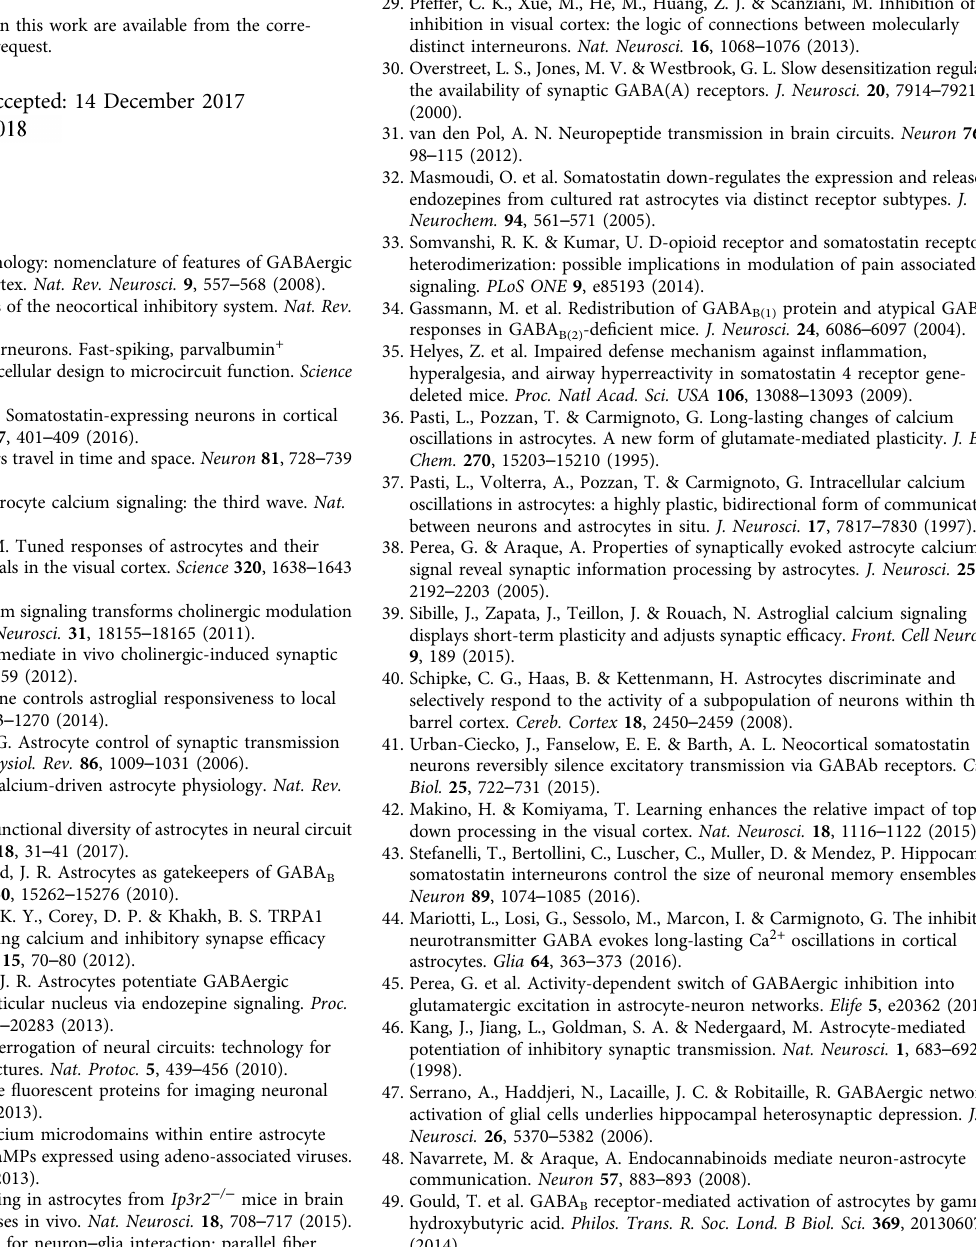
Mean IPSCs peak amplitudes in Supplementary Fig. 13 were fi tted to the double exponential equation A ( t ) = A 1*exp( − x / t 1)+ A 2*exp( − x / t 2), where A 1 and A 2 are the amplitude of the fast and the slow decay component and t 1 and t 2 are the corresponding decay time constants. Statistical analysis . Data were tested for normality before statistical analysis. For the number of ROIs and the frequency of astrocytic Ca 2+ events, we used paired Student ’ s t -test (on normal data distribution) or paired sample Wilcoxon signed- rank test (on non-normal data distribution). For the RR, one sample Wilcoxon signed-rank test was used. For cumulative distribution comparisons, we applied the Kolmogorov – Smirnov test. For EM data, normality test and statistical analysis were performed using GraphPrism v.4.0 (GraphPad Software, San Diego, CA, USA). Given the non-normal distribution of data, Mann – Whitney test and Kruskal Wallis with Dunn ’ s multiple comparison test were used. Pairwise statistical comparisons of each value of the astrocyte response to a given stimulation was carried out with respect to basal values. The astrocytes response to the two successive 10 (or 30) pulse stimulation was also similarly evaluated. All results are presented as mean ± SEM. Results were considered statistically signi fi cant at p ≤ 0.05. * p ≤ 0.05, ** p ≤ 0.01, *** p ≤ 0.001. The exact p- values for each set of data are reported in